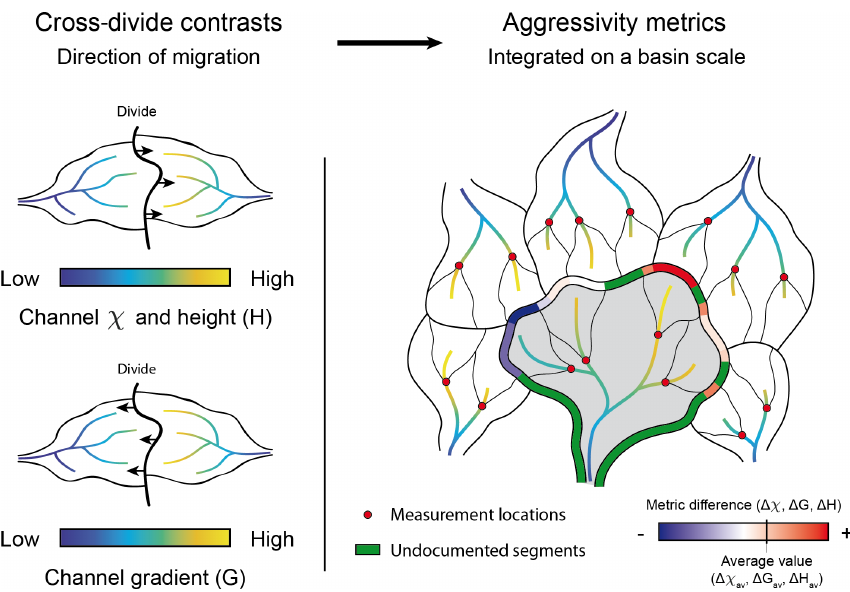
Figure 2. Conceptual relationship between cross-divide contrast in χ and Gilbert metrics and divide migration as exposed by Willett et al. (2014) and Forte and Whipple (2018). For χ and height, divides migrate toward the drainages that present higher values. For channel gradient, divides migrate toward the drainages that present lower values. In our study, channel χ , local gradient and height are measured at the outlet (indicated by red circles) of basins for a reference area (basins bounded with thin black lines). Aggressivity metrics are then calculated for a given basin (represented in grey) by averaging along its perimeter the individual cross-divide differences in metrics between reference basins. The proportion of perimeter which is not shared by two reference basins is measured to give a confidence index of the calculated